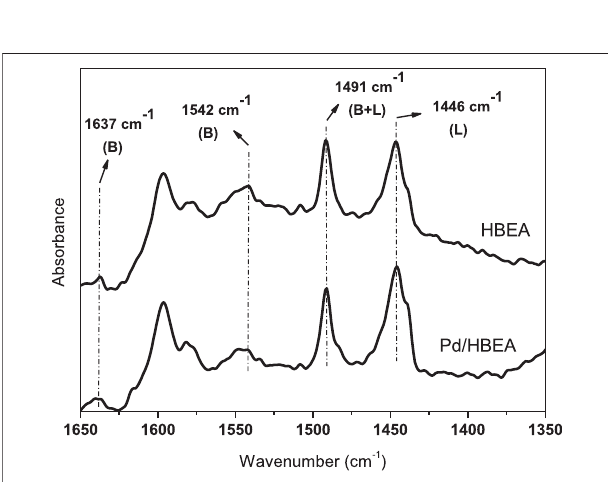
FIGURE2| FTIRspectraobtainedfromadsorbedpyridineonHBEAand Pd/HBEA catalysts. Legend: B (cid:1) Brønsted acid site; L (cid:1) Lewis acid site; B + L (cid:1) overlapping of peaks attributed to Lewis and Brønsted acid